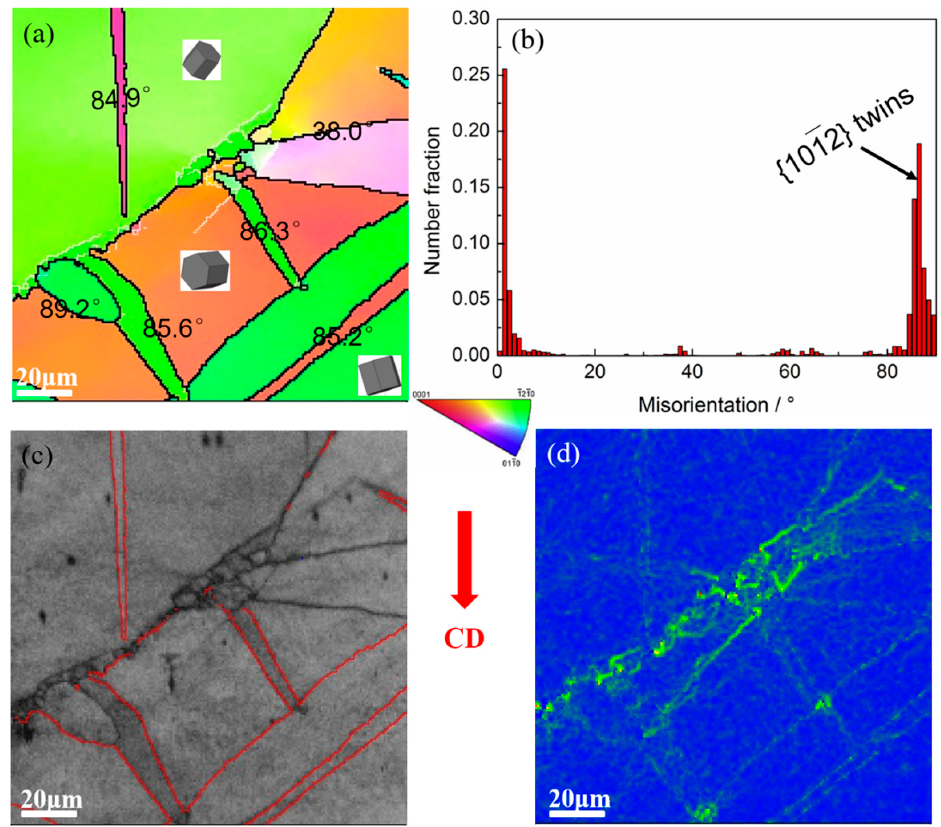
Figure 3. EBSD results of the Mg-5Zn alloy with a compression strain of 0.1: ( a ) IPF map, ( b ) misorientation map, ( c ) BC map and ( d ) KAM map.